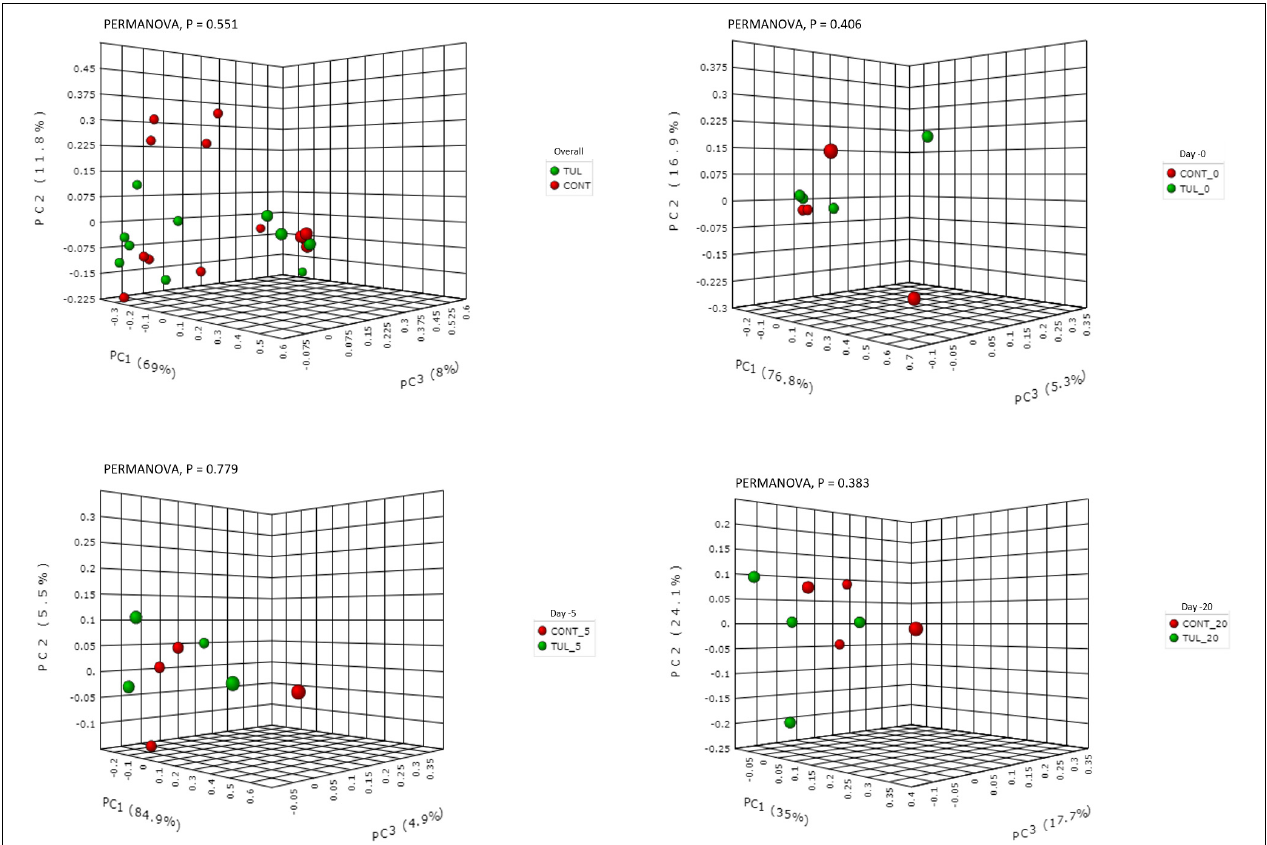
FIGURE 5 | Principal component analysis (PCA) based on non-phylogenetic Bray–Curtis distance metrics for control (CONT) and tulathromycin (TUL) piglets at different sampling days (0, 5 and 20). The percent variation explained by each principal component is indicated on the axes. Significance between the two groups was analyzed using PERMANOVA with 9999 permutations and Bonferroni corrected P-